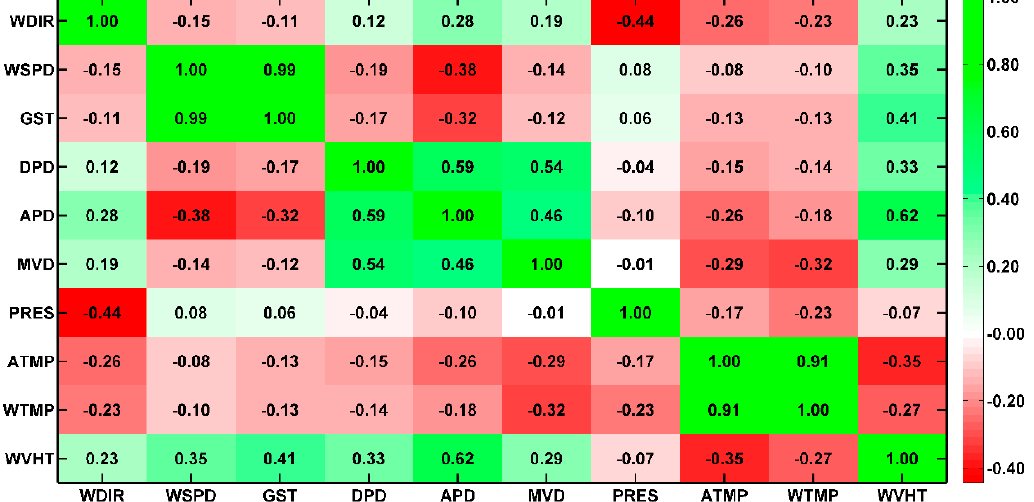
Table 2. Comparison of IF and CC. Statistically significant values at the 90% level are highlighted.